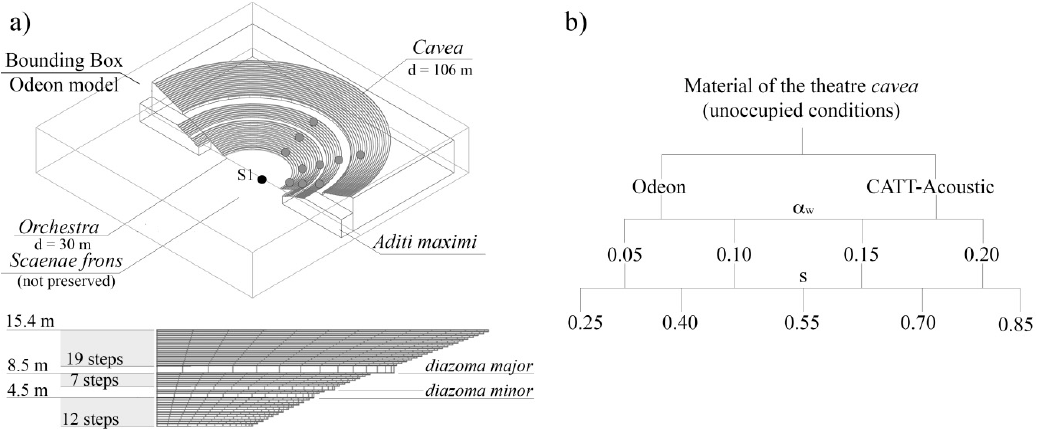
Figure 3. 3D model and source-receiver simulation set-up of SR ( a ) and scheme of the characteristics of the material chosen for the cavea ( b ).